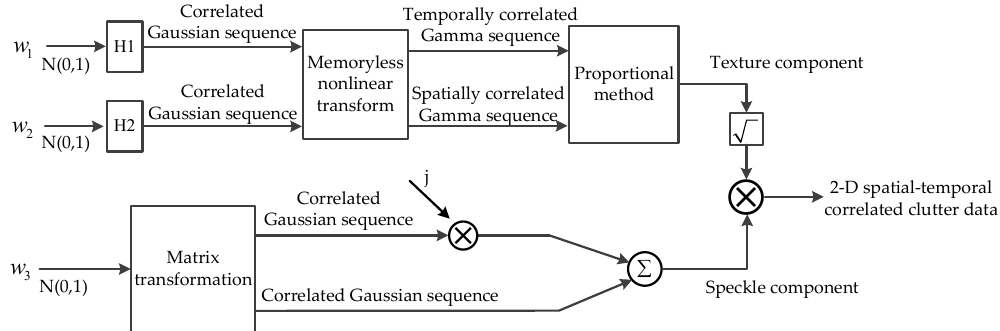
Figure 8. Block diagram of spatial–temporal correlated proportional method (STCPM) for generation of K-distributed clutter with spatial–temporal correlation.